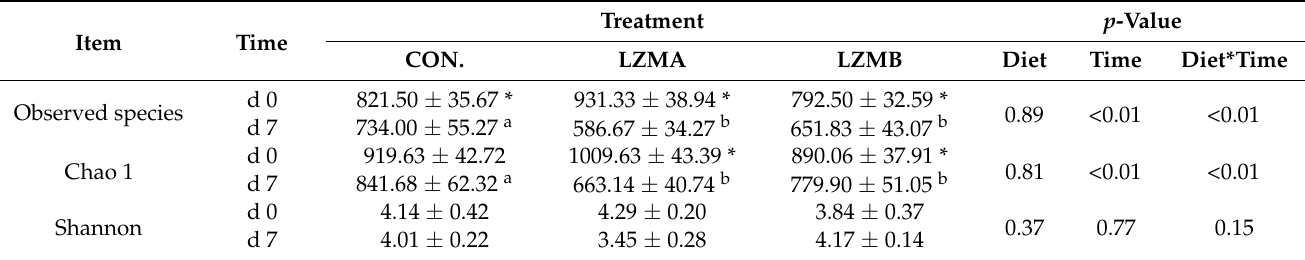
Data are expressed as mean ± SD. Sows were regarded as the experimental units, n = 6 for each treatment. CON. = control diet, LZMA = control diet + lysozyme 150 mg/kg, LZMB = control diet + lysozyme 300 mg/kg. d 0 = day of farrowing, d 7 = day 7 of lactation. a,b Within a row, means with different superscripts are different ( p < 0.05). * Within a column in the same index at different day, means with asterisk denotes different ( p <